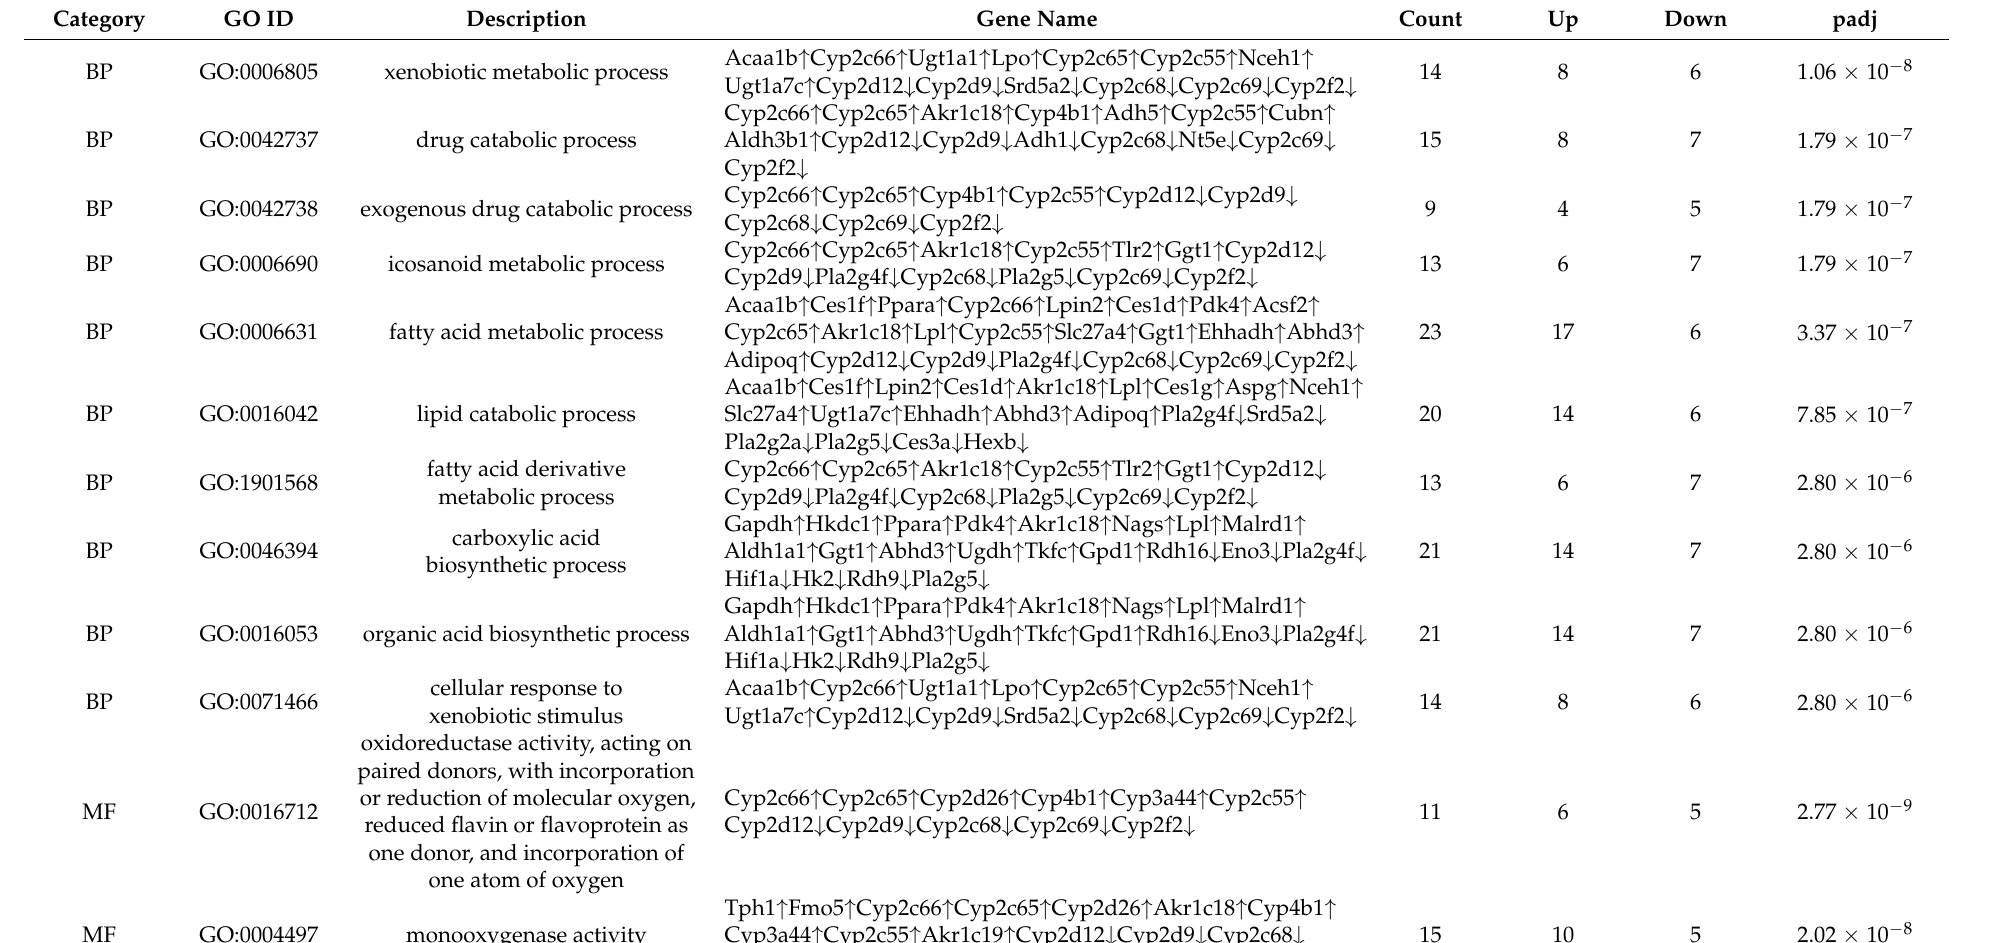
Table 4. List of GO terms enriched with colonic DEGs (padj <